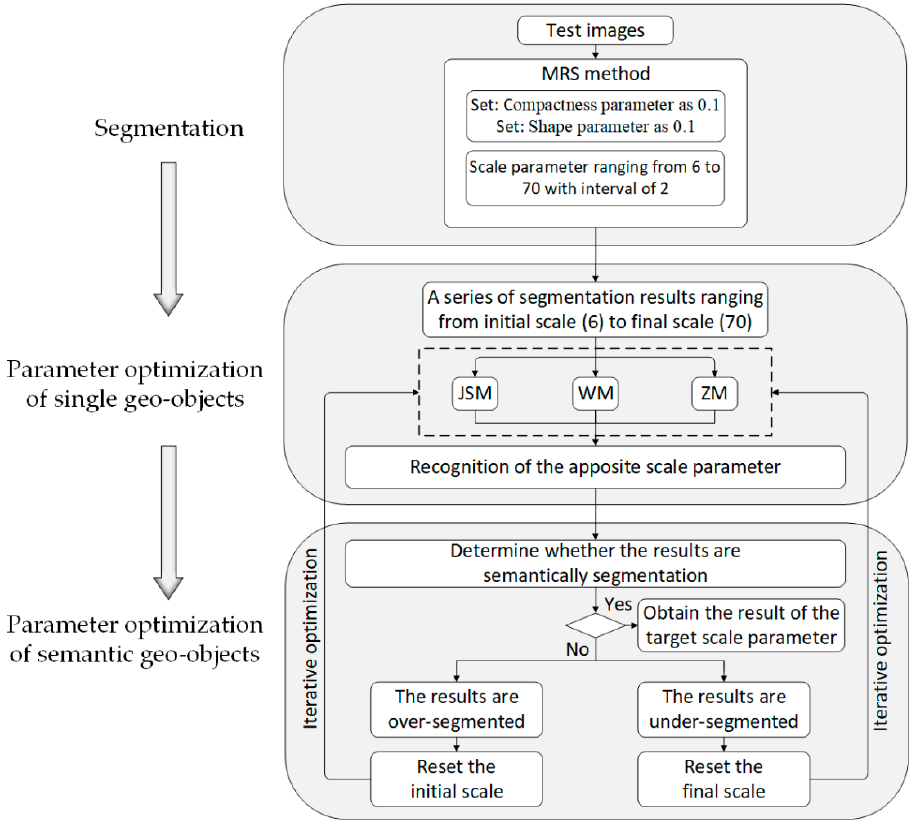
Figure 2. Process flow to determine the compatible semantic segmentation scale (the formulation of the workflow refers to the paper of Wang et al. (2021) [36] ).